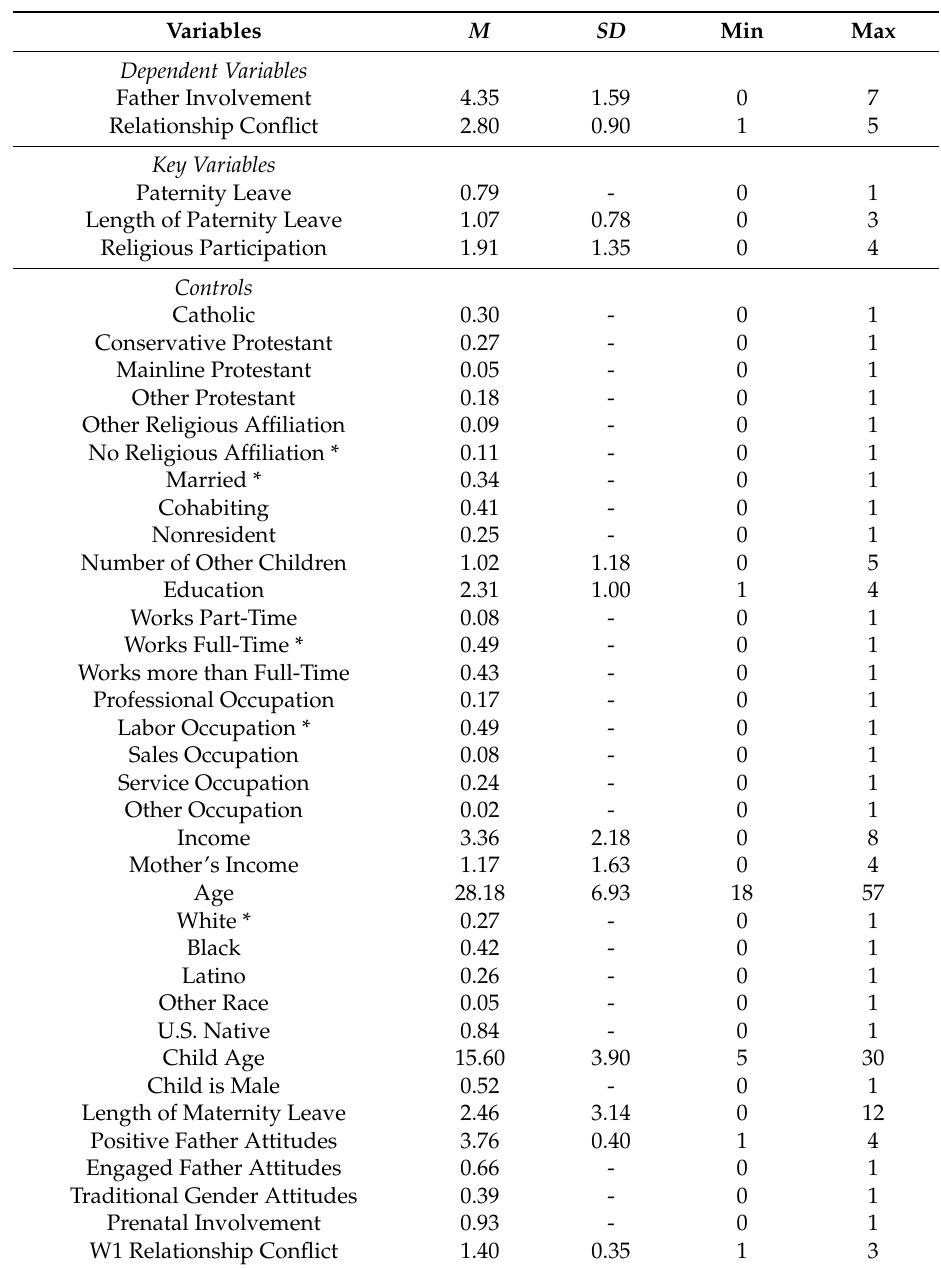
Table 1. Summary Statistics at